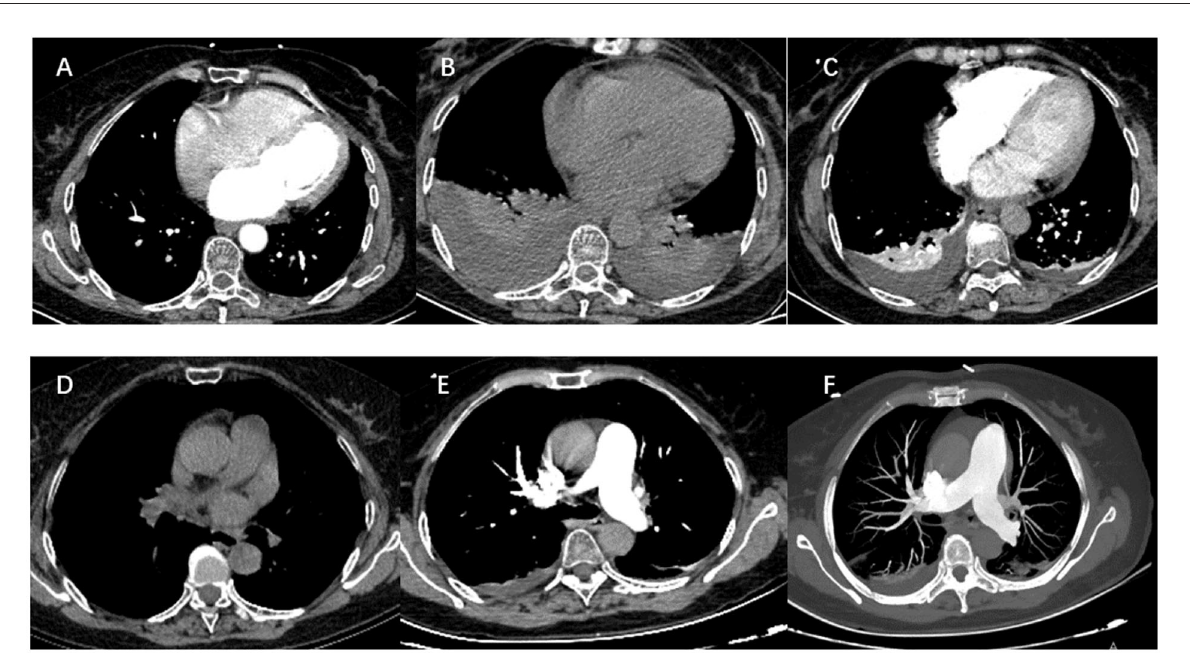
FIGURE1 The dramatic transition of a thoracic CT scan (soft-tissue window) and pulmonary computed tomography angiography. (A) Preoperative tests: CT revealed clear lung fields bilaterally. (B) Three days after operation: CT scan showing large bilateral pleural effusions without pericardial effusion. (C) Nine days after the operation: there is a resolution of the left pleural effusion and a marked decrease in the right pleural effusion. (D) Nineteen days after operation: there is no pleural effusion on CT images. (E,F) Pulmonary computed tomography angiography ruled out pulmonary